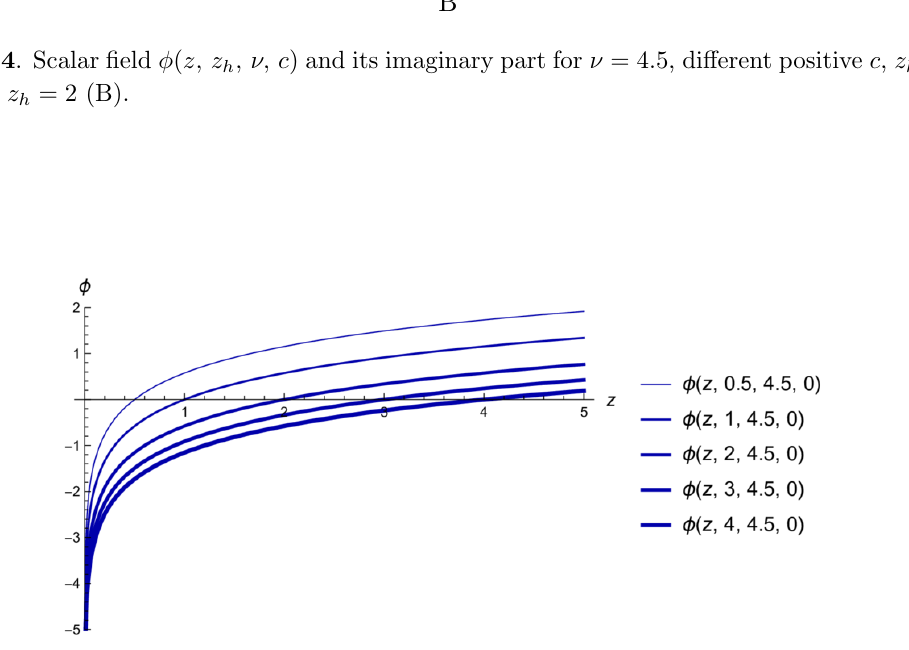
Figure 5 . Scalar (cid:12)eld (cid:30) ( z; z h ; (cid:23); c ) for (cid:23) = 4 : 5, c = 0 and di(cid:11)erent z h .